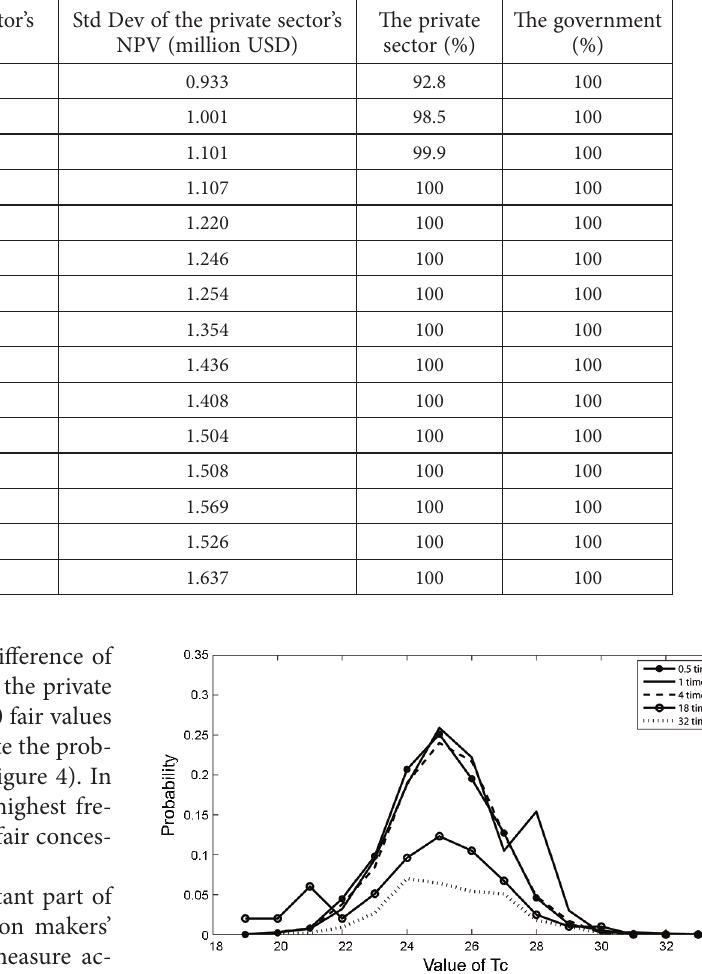
Figure 5. The probability of the value of c T based on the fluctuant inequality aversion